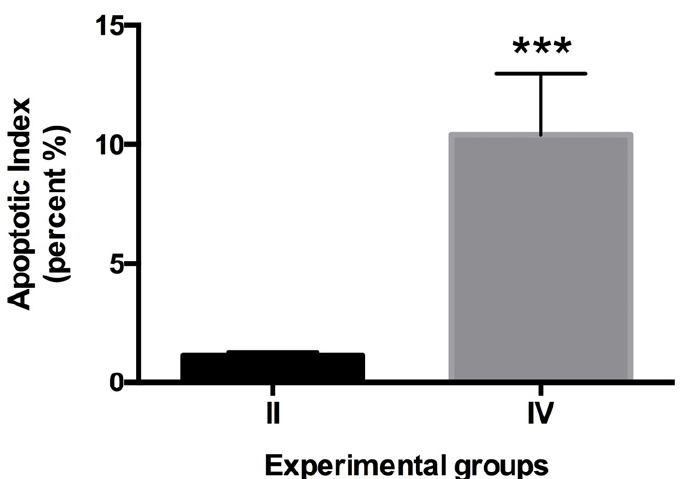
Figure 9. Apoptotic index. The index was higher in group IV (urethane-V) compared with group II (urethane). N = 10, values are expressed as mean percentage of TUNEL positive nuclei ± SEM (two-tailed Student’s t -test with Welch’s correction p ≤ 0.05). *** Statistically significant differences between group II versus group IV.